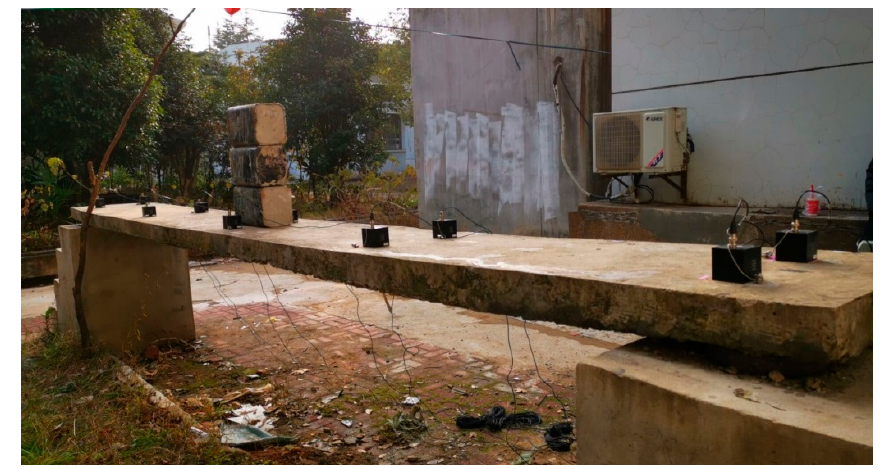
Figure 12. The simply supported reinforced concrete plate with additional mass blocks. Table 6. Eight cases of the simply supported reinforced concrete